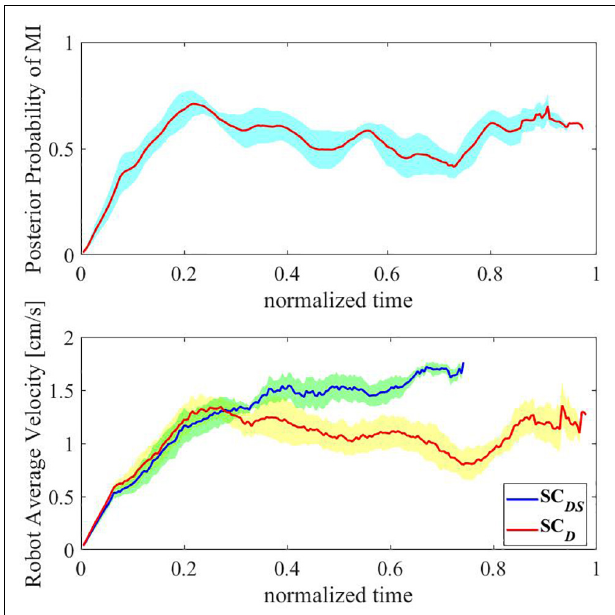
FIGURE 12 | The evolving posterior probability values calculated by the BMI and the evolving speeds of the end-effector with SC DS and SC D in a normalized time scale (subject 1).